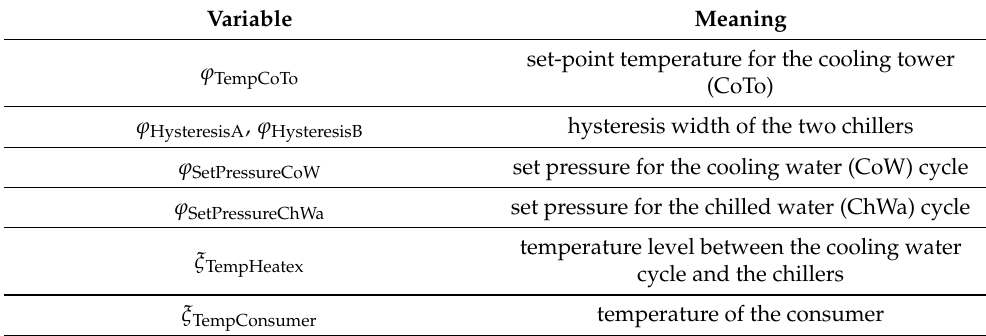
Table 1. Nomenclature of EnPI: adjustable parameters ϕ and arbitrary but fixed parameters ξ .